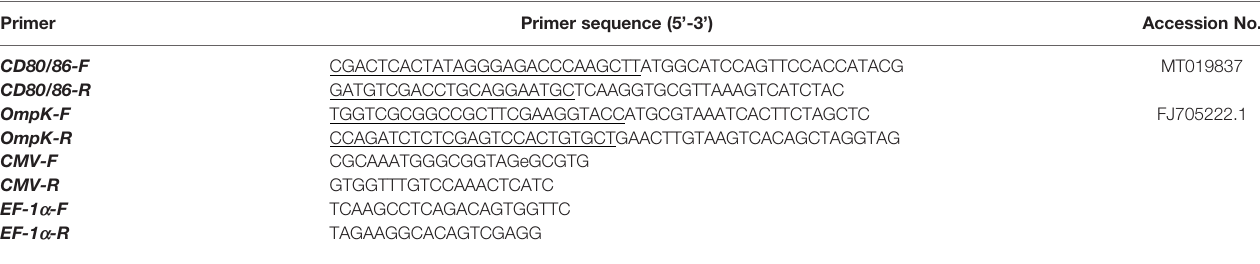
TABLE 2 | Primer sequences for plasmid